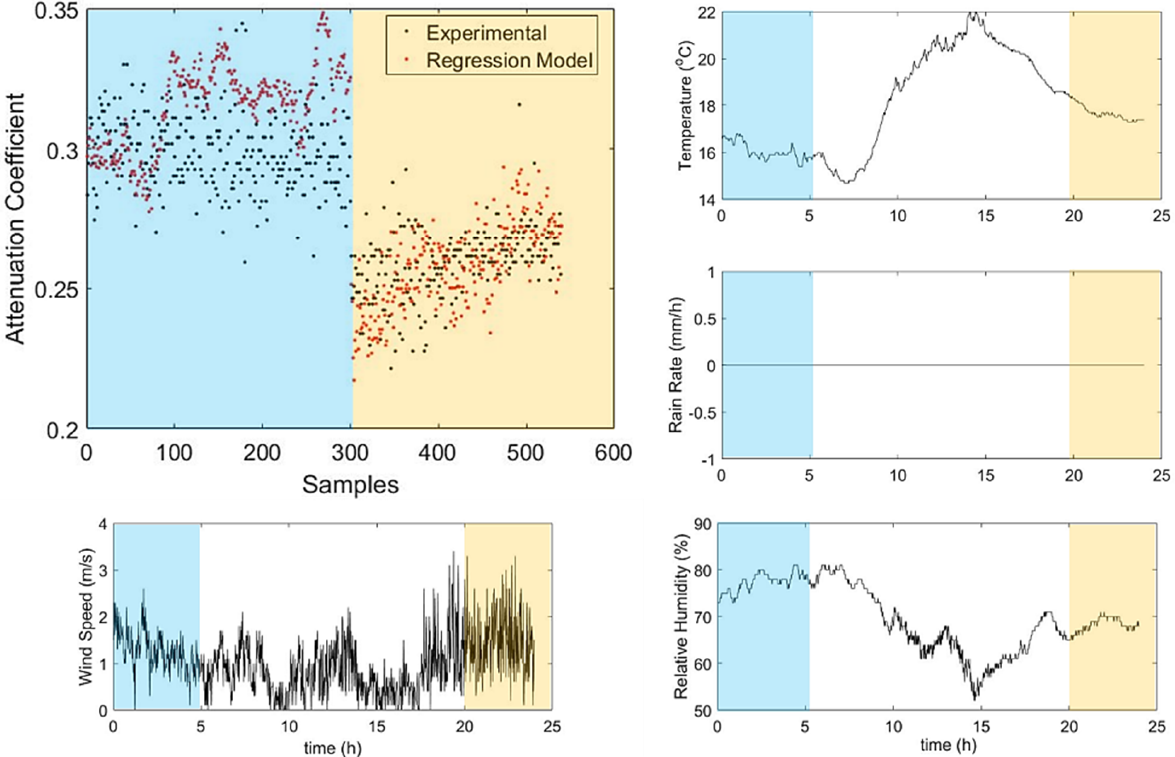
Figure 10. Experimental measurements and model predictions, i.e., Equation (6), for 16 November 2019.